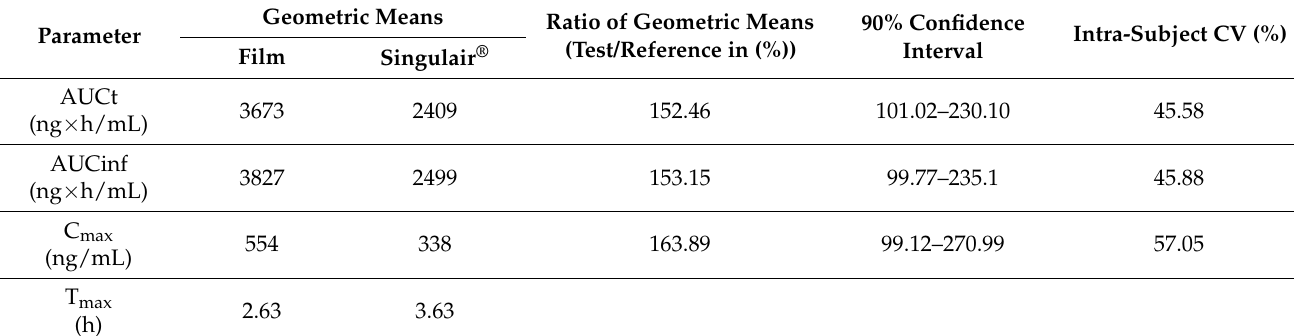
CV: Coefficient of Variation. AUCt: area under the concentration–time curve from time zero until the last measurable concentration or last sampling time t, whichever occurs first. AUCt is estimated using the trapezoidal method. AUCt/AUCinf: the proportion of AUCinf covered by the actual sample schedule. AUCinf: area under the concentration–time curve from time zero to infinity, calculated as AUCt + Clast/ λ , where Clast is the last measurable concentration. C max : the maximal observed plasma concentration. T max : time when the maximal plasma concentration is observed.